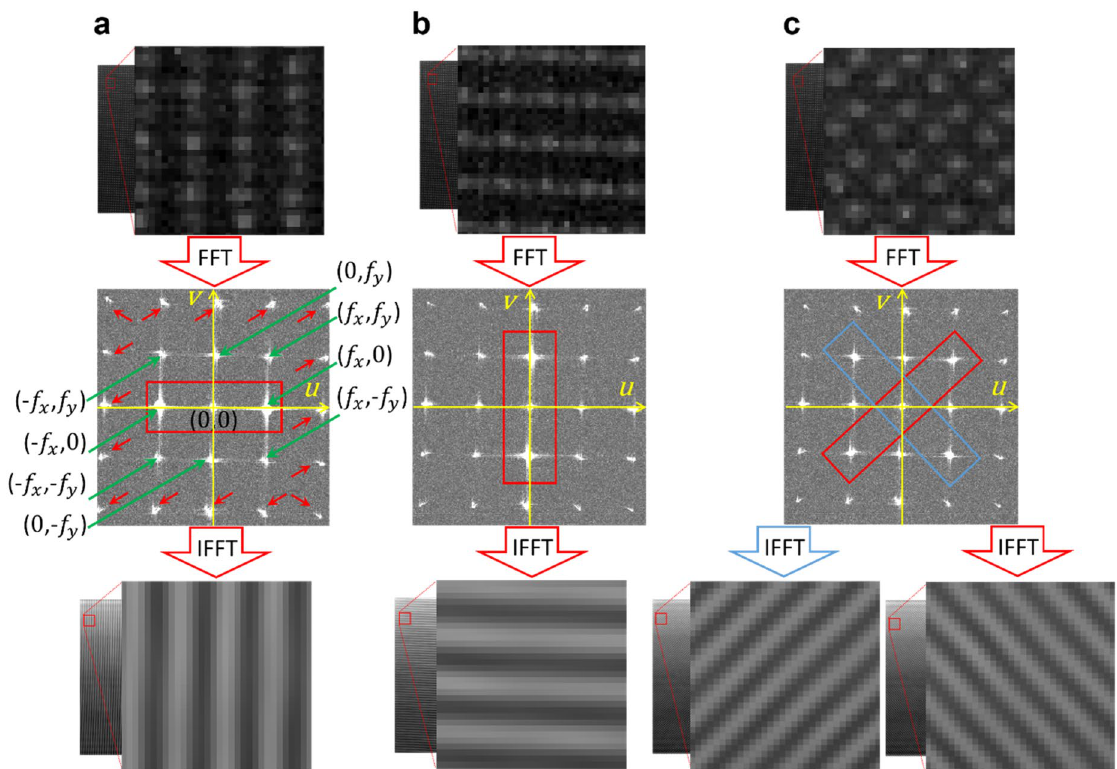
Figure 10. Fringe extraction method. ( a ) From top to bottom: image of the combination of spectral images F1 and F3 showing a magnified view of a small region indicated by the red box; 2D fast Fourier transform (FFT) of data in upper panel showing ± 1 order frequency components (green arrows), and harmonics (red arrows); 2D inverse fast Fourier transform (IFFT) of data in upper panel that has been masked to only include the (cid:31) f x , 0 (cid:30) , (cid:31) − f x , 0 (cid:30) , and ( 0, 0 ) frequency components. ( b ) Extraction of horizontal fringes from the F1 to F2 combination and ( c ) extraction of two diagonal fringes from the F2 to F3 combination. A magnified view of a small region of the larger data set is indicated by the red